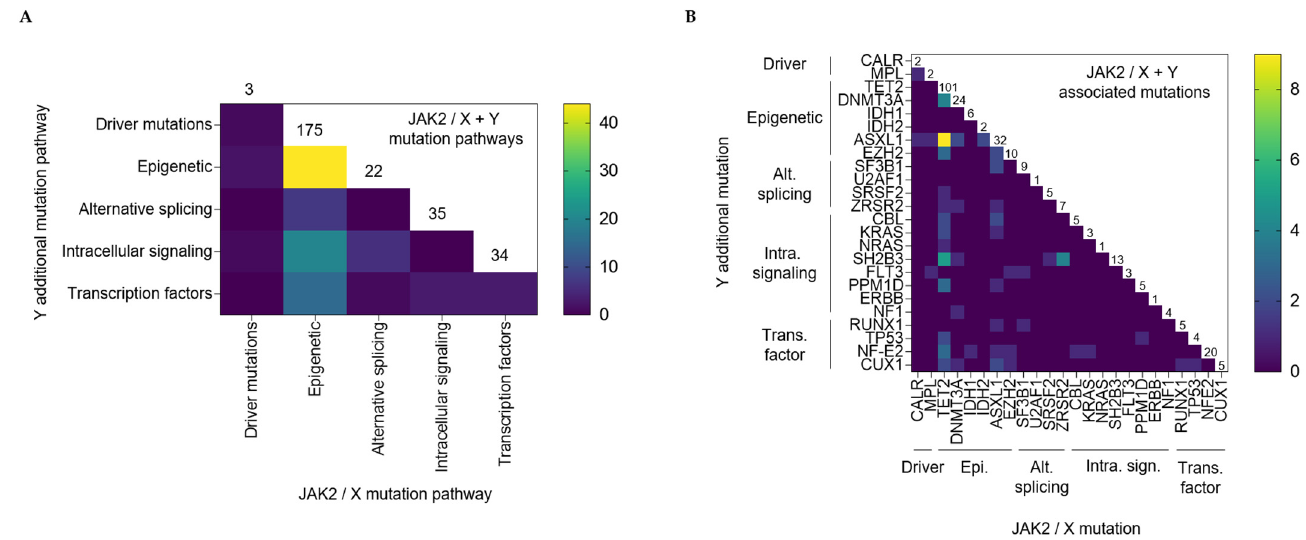
Figure 4. Heat map view of JAK2 paring with additional MNAMs in 7 PV patients cohort reports (Figure 2). ( A ) Heat map representation of JAK2/affected pathway association with another MNAM that belongs to one of the 5 affected pathways (e.g., the triple association of JAK2 + one of epigenetic affected gene + one of intracellular signaling affected gene is found in 20 cases among the total of 175 cases affected by a JAK2/Epigenetic association). The numbers above each colon represent the total cases of each JAK2/affected pathway (e.g., association of JAK2 + one of epigenetic affected gene is found in 175 cases). ( B ) Heat map representation of JAK2/affected gene with another MNAM (e.g., the triple association of JAK2 + TET2 + ASXL1 is found in 9 cases among the 101 cases affected by a JAK2/TET2 association.). The numbers above each colon represent the total cases of each JAK2/MNAM association (e.g., association of JAK2 + TET2 is found in 101 cases). Abbreviation: Alt. splicing = Alternative splicing; Epi. = Epigenetic; Intra. sign. = Intracellular signaling; Trans. factor = Transcription factor.